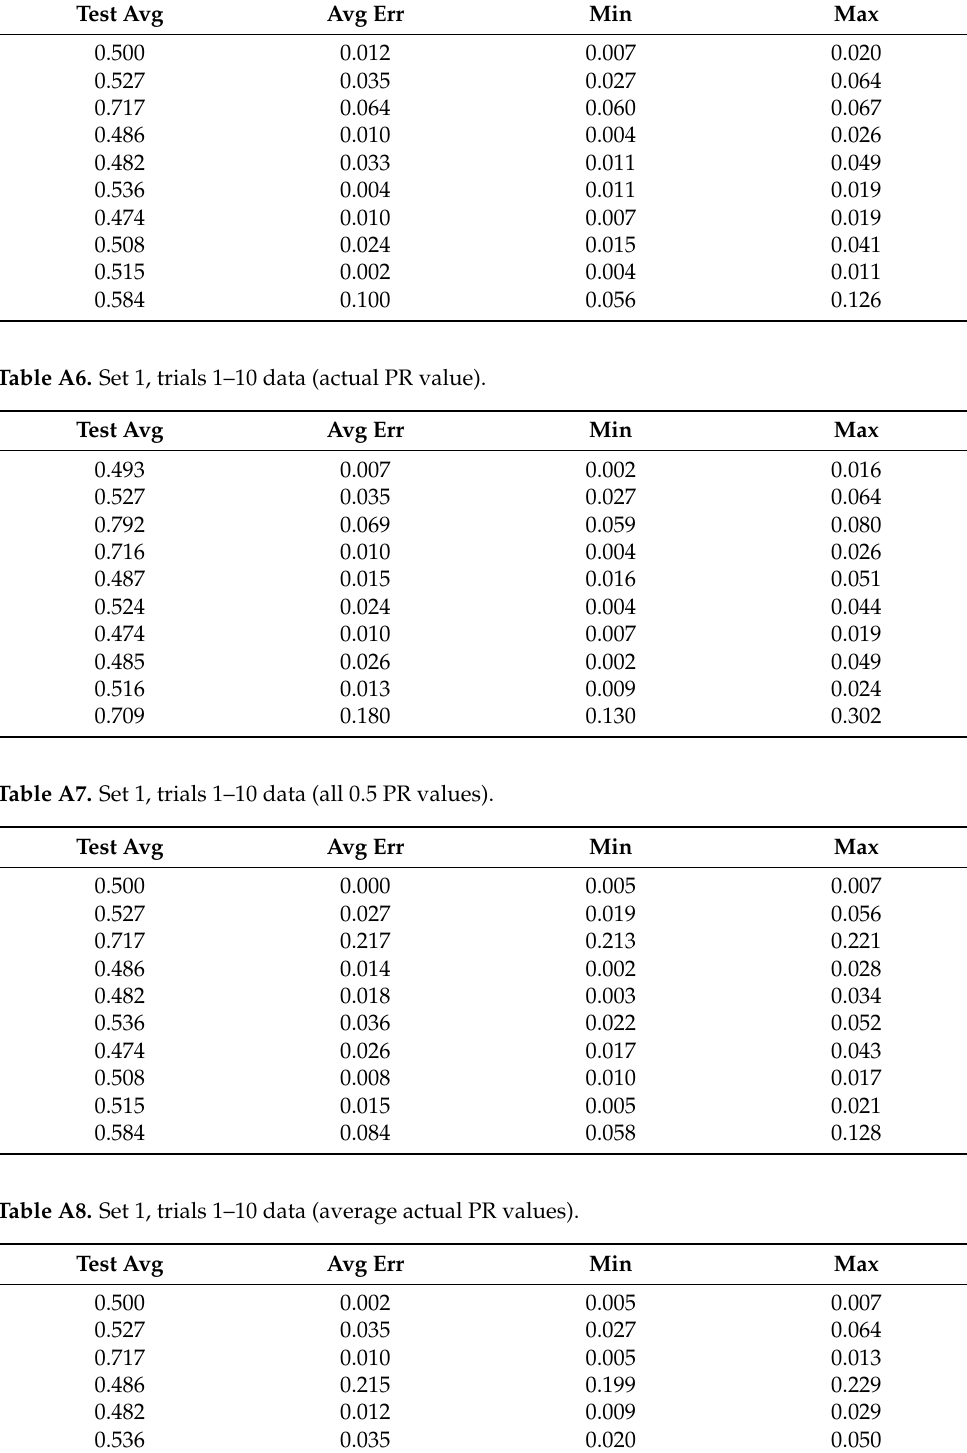
Table A5. Set 1, trials 1–10 data (single 0.5 PR value).